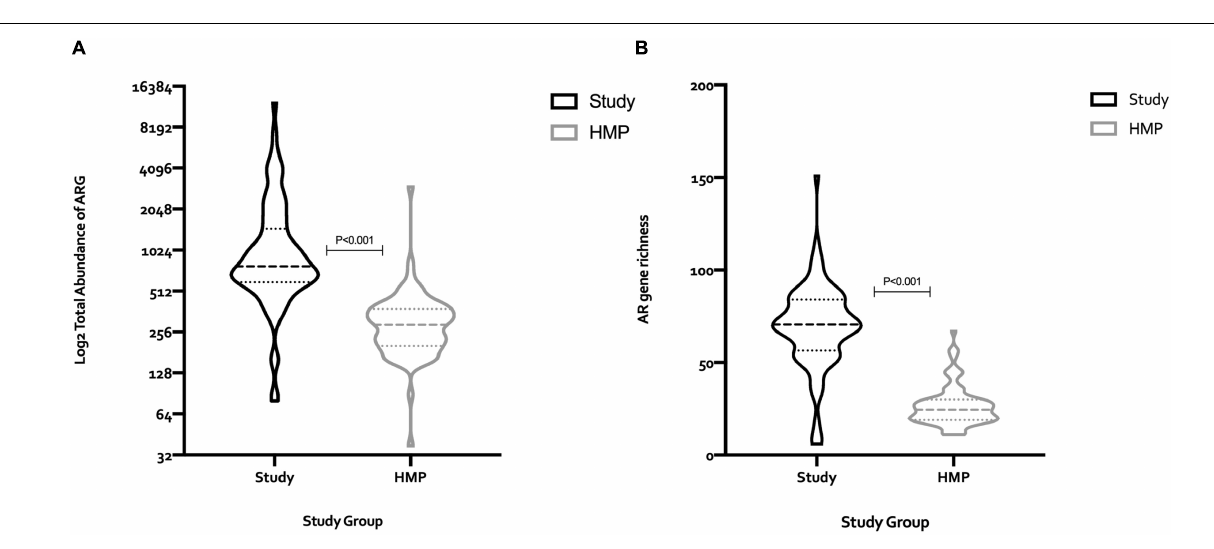
FIGURE 2 | Comparison of the total number of AR genes (RPKM), and AR gene richness between the 82 subjects in the study cohort, and 82 subjects from the human microbiome project (HMP). The median (IQR) number of AR genes among study subjects and HMP participants was 776.8 (594.6–1469) and 289.1 (202.1–378.4), respectively, (A) . The median (IQR) AR gene richness among subjects in the study cohort and the HMP was 70.5 (56.5–84) vs. 24.5 (19–30), respectively, (B) . Statistical differences between groups were determined using the Mann–Whitney test. RPKM, reads per kilobase of transcript per million mapped reads; HMP, human microbiome project; ARG, antimicrobial resistance